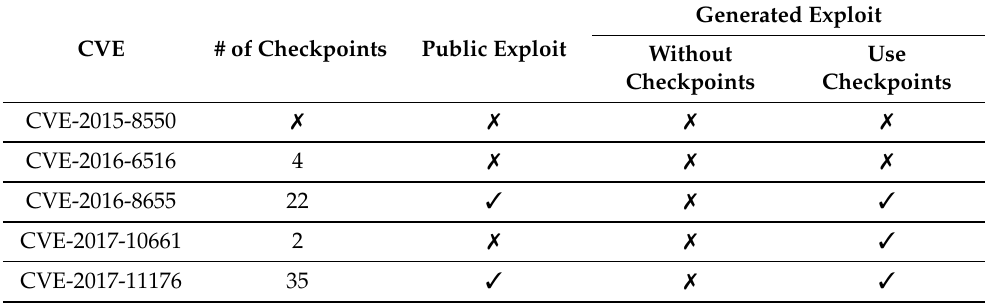
Table 2. Effectiveness of ERACE . # of checkpoints indicates the number of checkpoints ERACE could find. We compare whether the exploit succeeded in escaping privilege by using and not using checkpoints. (cid:55) means it has no checkpoints or public exploit, or it fails to exploit the vulnerability. (cid:51) means it has public exploit or it succeeds in exploiting the